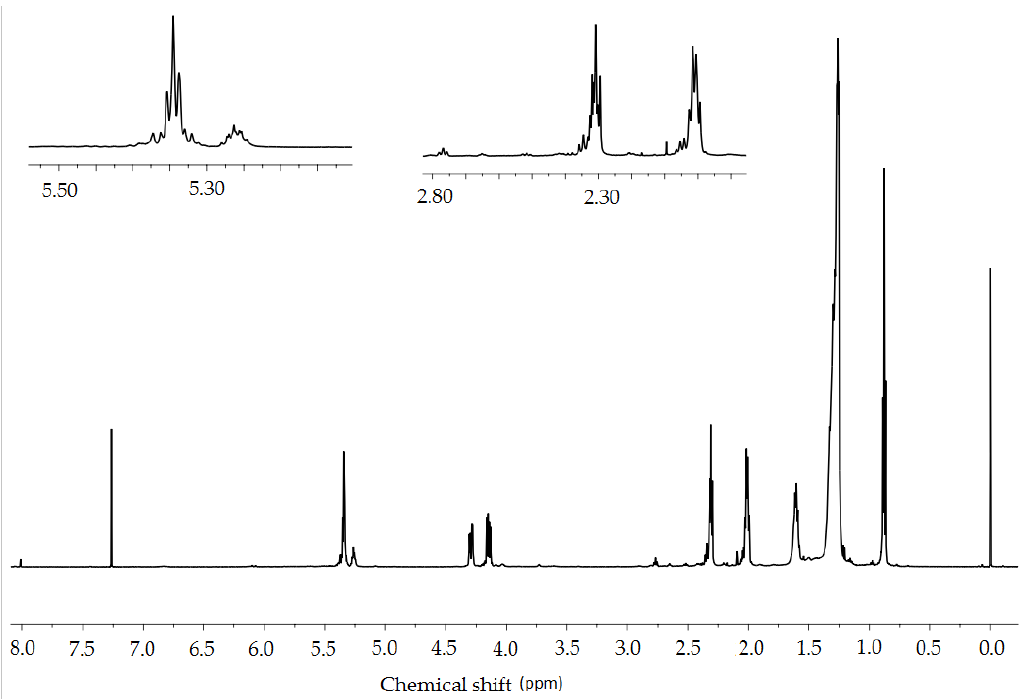
Figure 13. 1 H-NMR spectrum of modified Crambe abyssinica oil in the presence of oxygen.